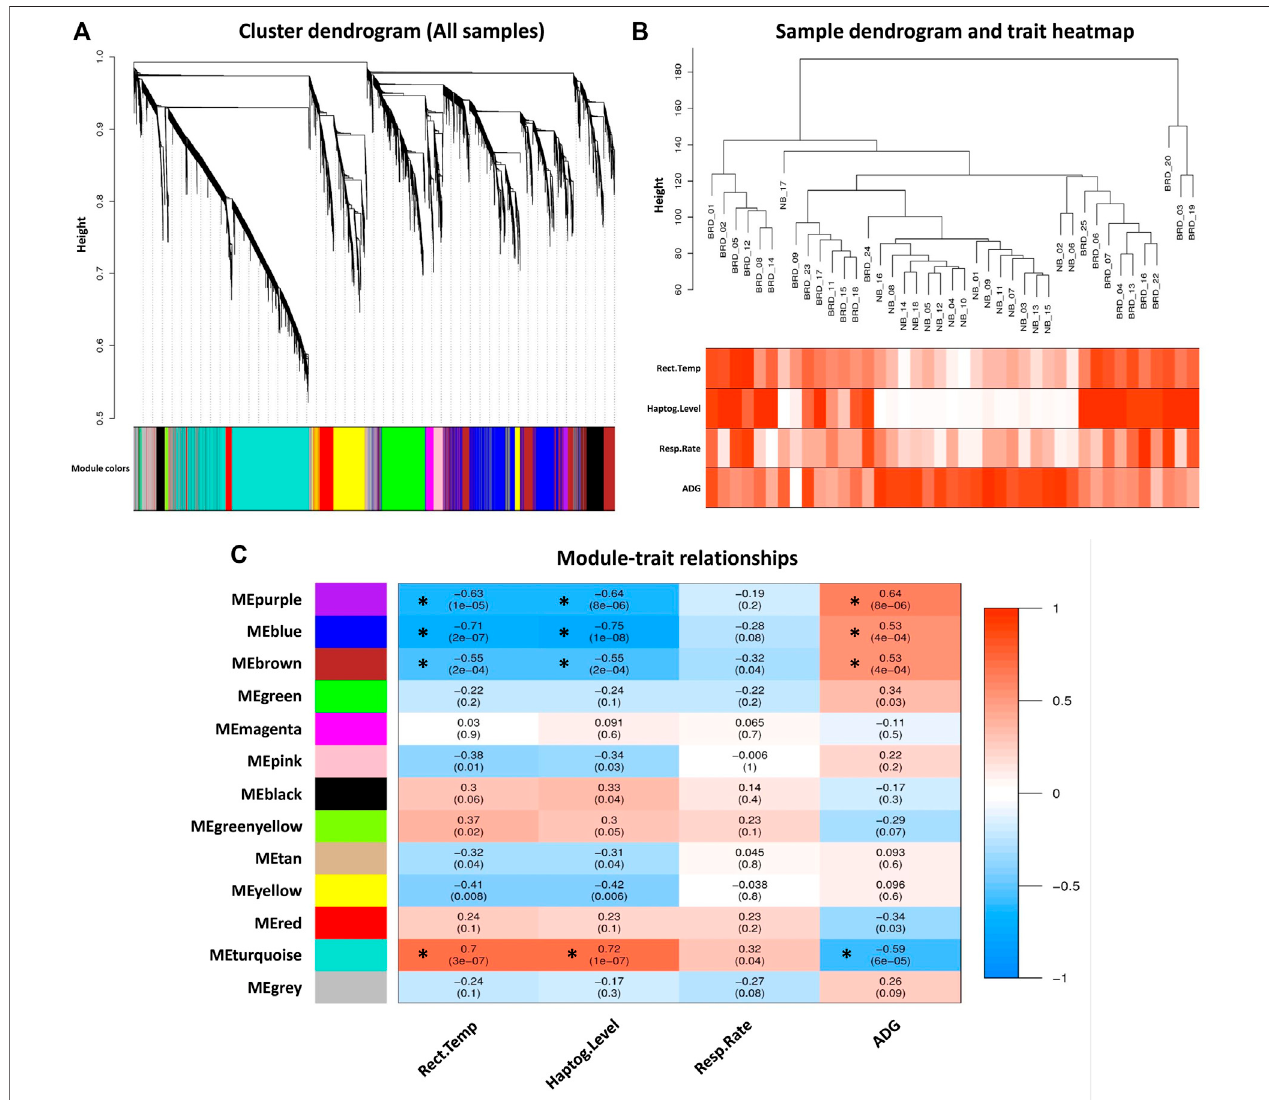
FIGURE 3 | Module – trait relationships analysis. (A) Gene hierarchical clustering dendrogram of 12 detected modules based on a dissimilarity (1-TOM) measure across all samples, the y-axis represents the coexpression distance and the x-axis represents the genes. The branches indicate the modules, and each module is markedwithaseparatecolor,thegraymoduleencompassgenesthatarenotassignedtoanyofthemodules. (B) Sampledendrogramandtraitheatmapofclinicaltraits relatedtoBRDacrossallsamples.Thegradientfromwhitetoredindicatesthelowtohighleveloftherespectivetraitsinthesamples. (C) Module – traitrelationships between detected modules and clinical traits of BRD. Module – trait relationships are obtained by calculating the correlation between the traits and the module eigengenes. The red and blue colors indicate strong positive correlation and strong negative correlation, respectively. Rows represent module eigengene (ME) and columns indicate clinical traits of BRD. Rect. Temp, rectal temperature ( ° C); Haptog. Level, haptoglobin level (g/L); Resp. Rate, respiratory rate (per min), ADG, average daily gain. Asterisks corresponds to signi fi cant highly correlated